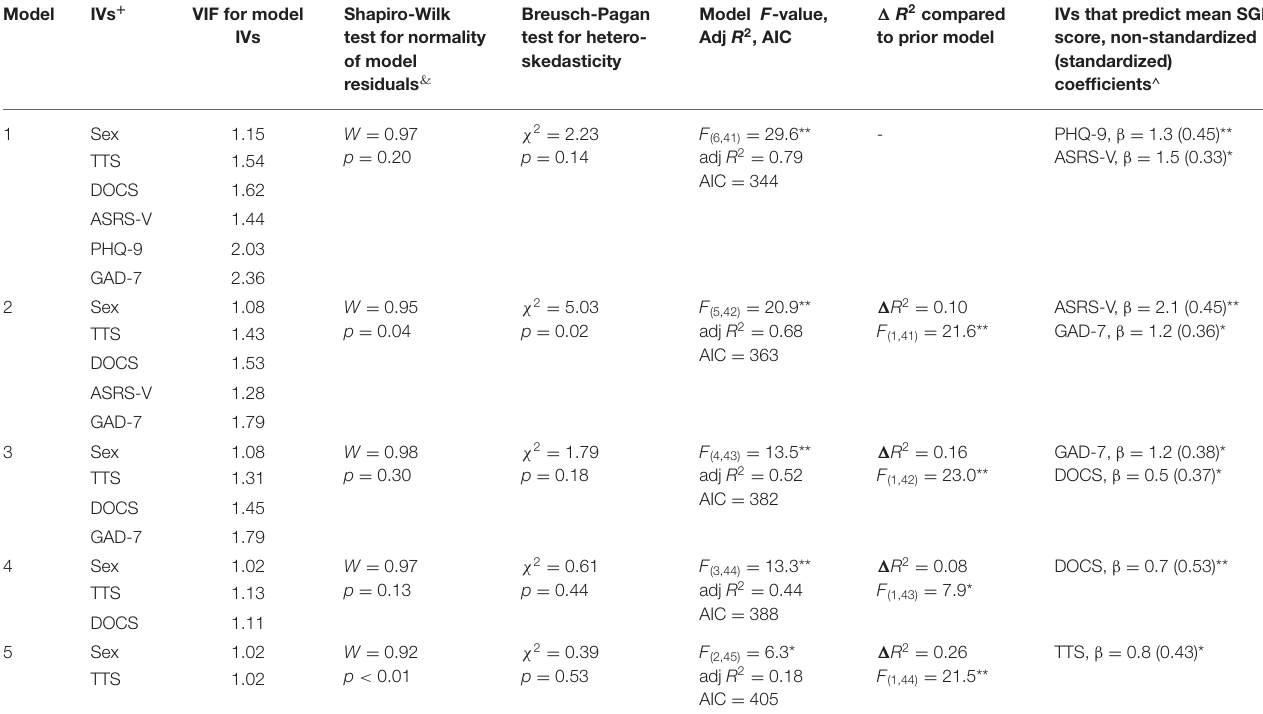
TABLE 5 | Hierarchical regression analysis with GTS-QOL total score as dependent variable. Model IVs +